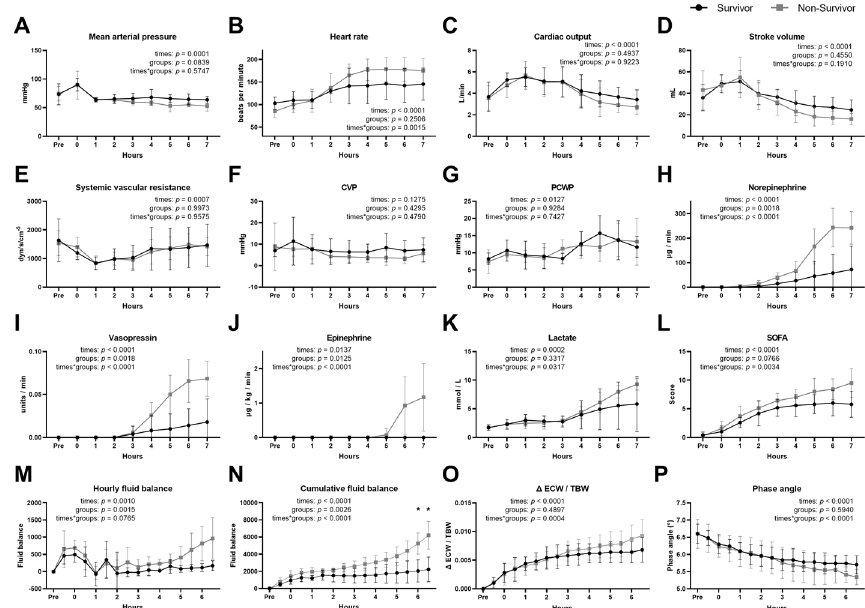
Fig. 4 Comparisons of trends in hemodynamic variables ( A – F ), PCWP ( G ), vasopressors ( H – J ), lactate ( K ), SOFA score ( L ), hourly fluid balance ( M ), cumulative fluid balance ( N ), ΔECW/TBW ( O ), and phase angle ( P ) between survivors ( n 5) and non-survivors ( n 7) in the E. coli -induced porcine bacteremia model. = = Data are presented as the means and standard error of the mean. The p values between times, groups, and times*groups using two-way RM ANOVA are denoted in each graph. Asterisks (*) indicate statistical significance of difference ( p < 0.05) using Sidak’s multiple comparison tests. CVP central venous pressure, PCWP pulmonary capillary wedge pressure, SOFA sequential organ failure assessment, ECW extracellular water, TBW total body